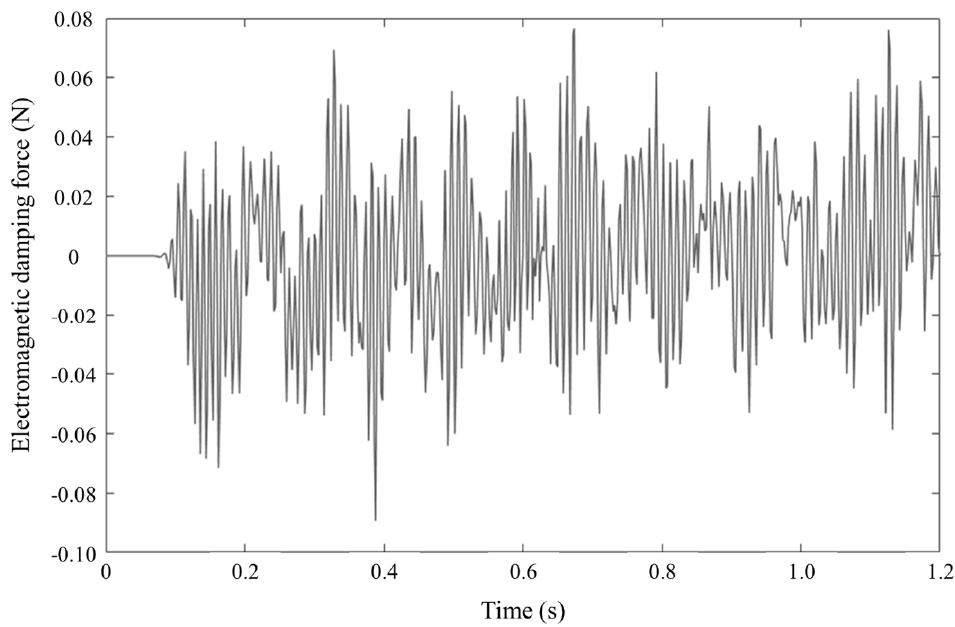
Figure 18. The coil electromagnetic damping without the energy harvesting.